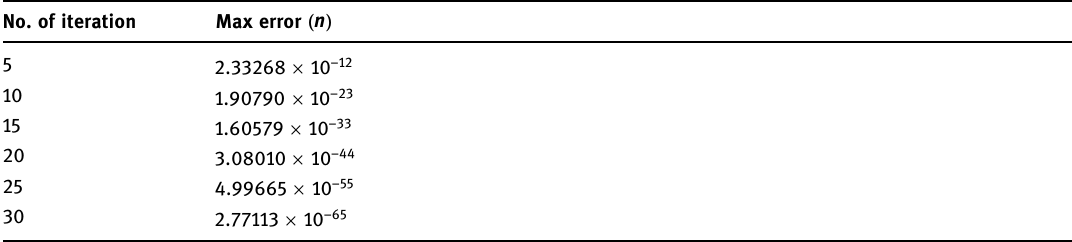
Table 4: Maximum absolute errors of Example 2